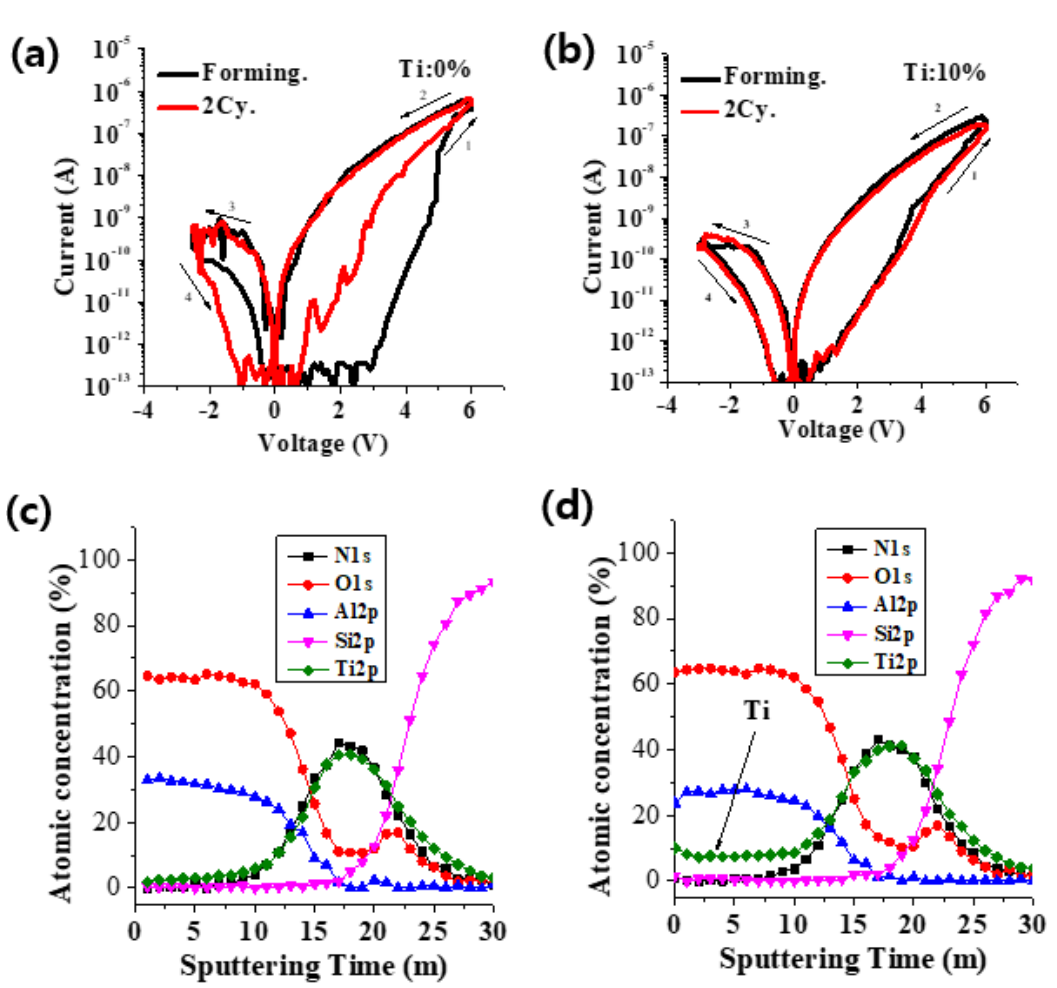
Figure 2. ( a , b ) show the DC I–V characteristics of the Ti 0% and 10% RRAM devices, respectively. ( c , d ) show the AES depth profile of devices.